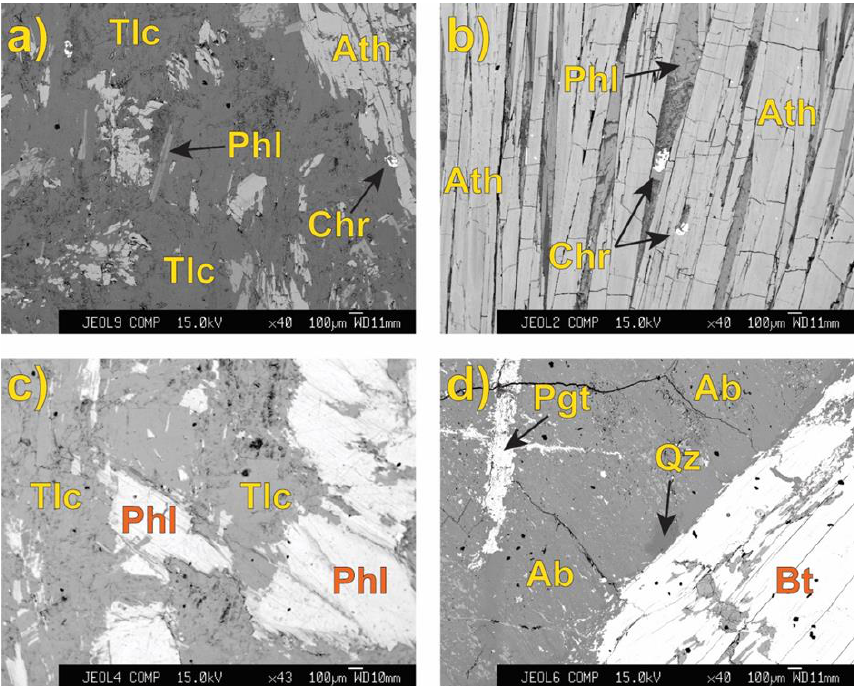
Figure 6. Back-scattered electron (BSE) images of the Seqi samples. ( a ) Talc zone; ( b ) Amphibole zone; ( c ) Mica zone; ( d ) Trondhjemitic pegmatite. Abbreviations: Ab (albite), Ant (anthophyllite), Bt (biotite), Chr (chromite), Pgt (pigeonite), Phl (phlogopite), Tlc (talc).